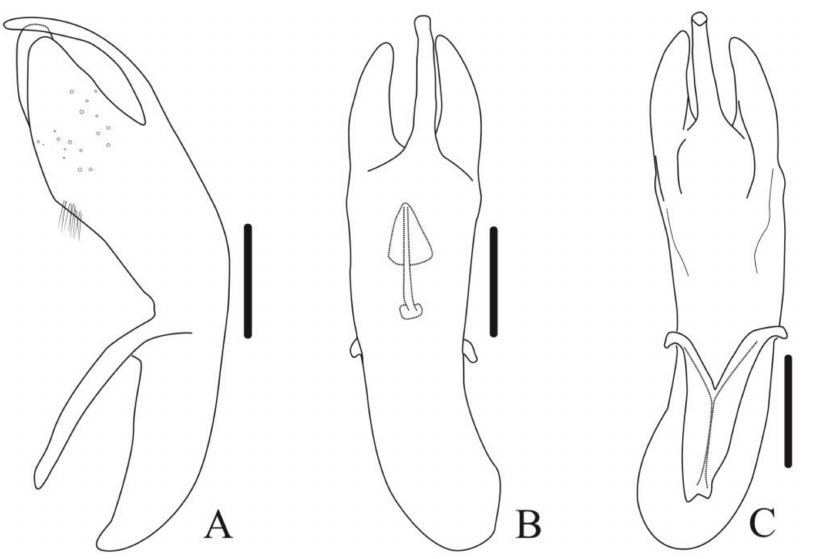
Figure 32. Cryptocephalus ( Burlinius ) scutemaculatus Tan, 1992: ( A ) lateral view of aedeagus; ( B ) dorsal view of aedeagus; ( C ) ventral view of